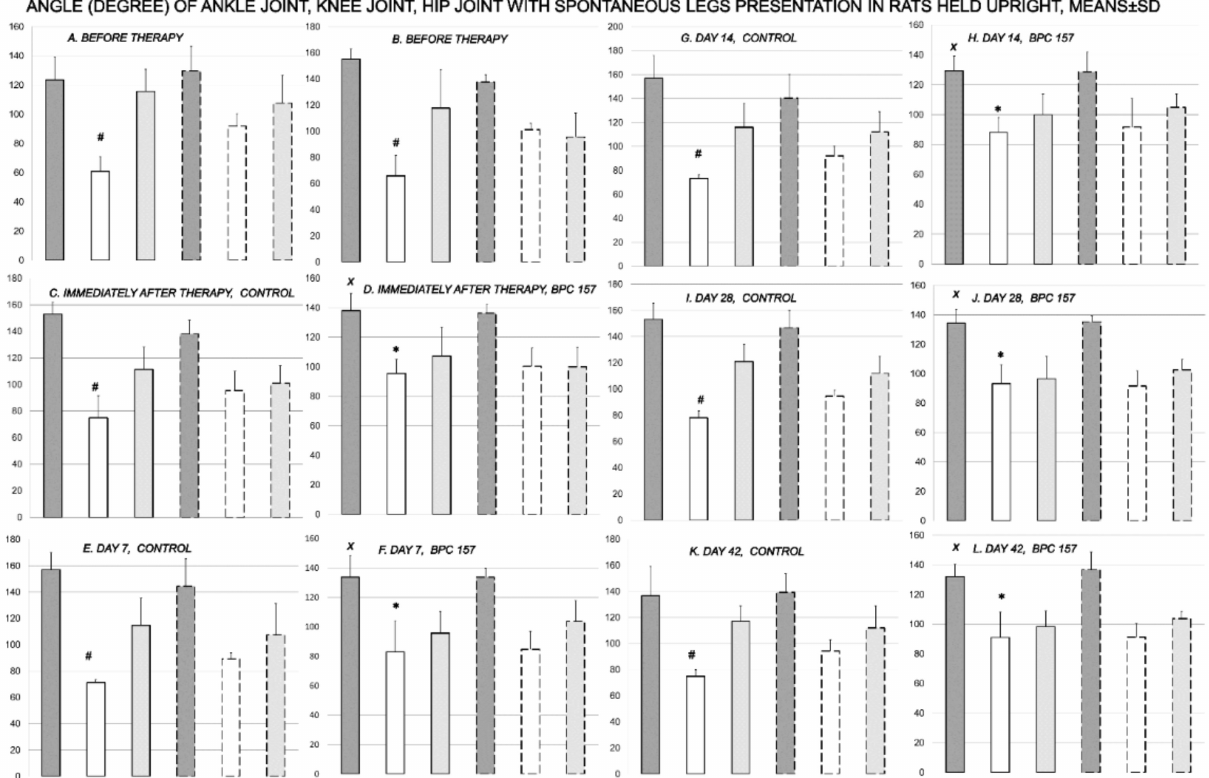
Figure 1. Rats, with the disabled myotendinous junction, were held upright to assess the degree of the angle of the ankle joint (dark gray bars), knee joint (white bars), and hip joint (light gray bars), and to verify spontaneous injured leg contracture (full bars) in comparison with the non-injured leg (dashed bars) after surgery, but before therapy ( A , B ); and subsequently, immediately after therapy application (control ( C ); BPC 157 ( D )) (day 0), and then at day 7 (control ( E ); BPC 157 ( F )), day 14 (control ( G ); BPC 157 ( H )), day 28 (control ( I ); BPC 157 ( J )) and day 42 (control ( K ); BPC 157 ( L )); providing the course for controls A (before therapy)— C (immediately after therapy)— E (day 7)— G (day 14)—I (day 28)— K (day 42), and for BPC 157 B (before therapy)— D (immediately after therapy)— F (day 7)— H (day 14)— J (day 28)— L (day 42). # p < 0.05, at least, vs. the corresponding knee joint at non-injured leg; x p < 0.05, at least, vs. ankle joint in corresponding control; * x p < 0.05, at least, vs. knee joint in corresponding control or presentation of the knee joint in the injured leg before therapy application. Illustrative presentation of BPC 157 regimens effects includes the effect of the application of BPC 157 10 ng/kg, initial intragastric, and then in drinking water while controls received water, initially as intragastric 1 mL application, and then drinking water (12 mL/rat/day) until the sacrifice. Likewise, the same presentation was obtained with rats, which were awake, anesthetized, or immediately after sacrifice (data not specifically